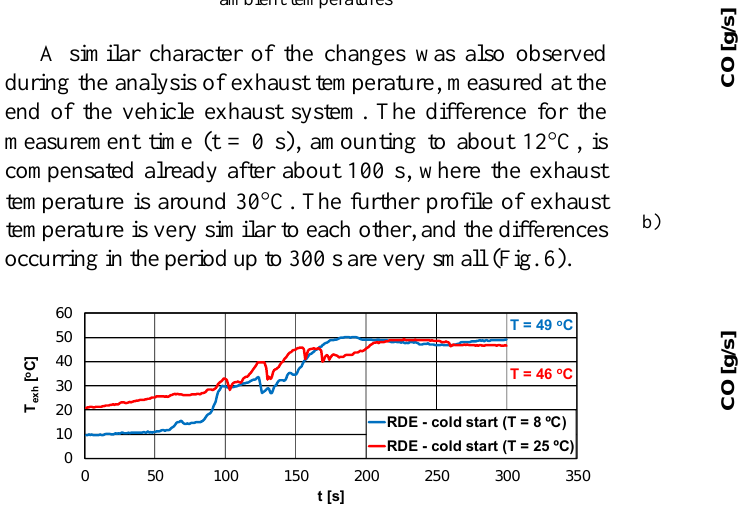
Fig. 5. The coolant temperature during the cold start phase at different ambient temperatures